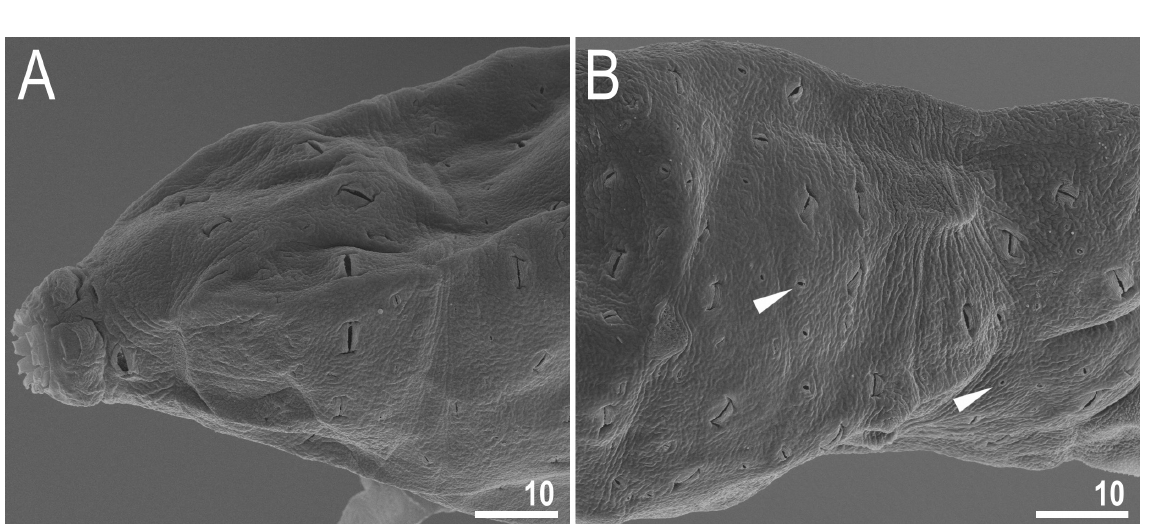
Fig. 2. Macrobiotus engbergi sp. nov. Cuticular pores (paratype). A – B . Cuticular pores on the dorso- cephalic and dorso-caudal part of the body seen in SEM, respectively. Arrowheads indicate small oval pores Scale bars in μm.